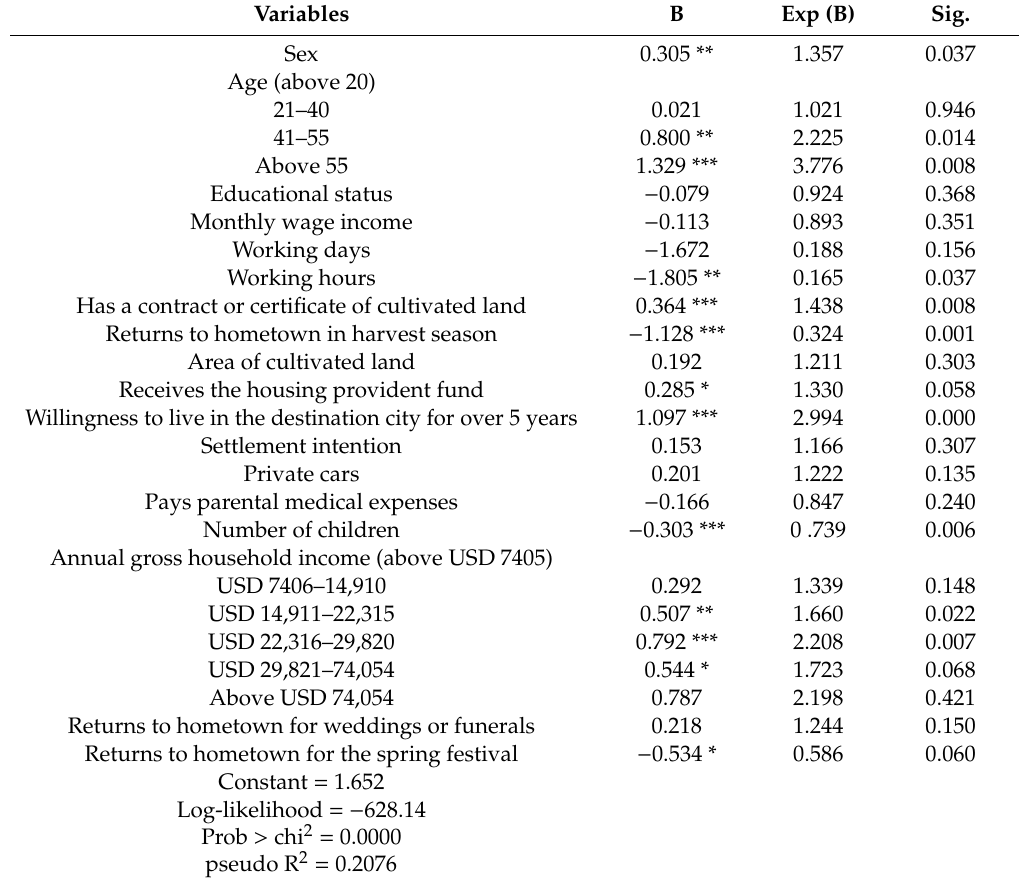
Table 3. Estimates of logistic regression of land rental by migrant